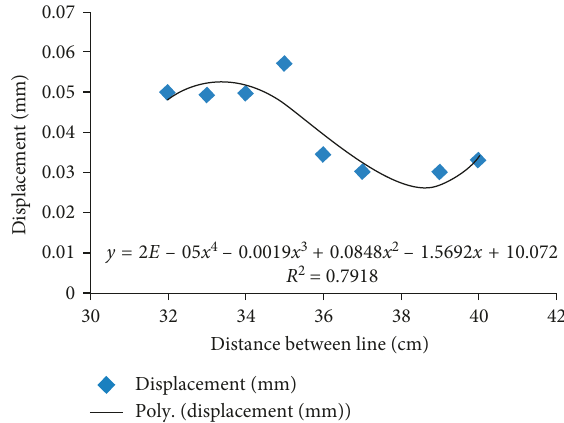
Figure 21: Deformation as a function of the distance between rows of holes in the staggered